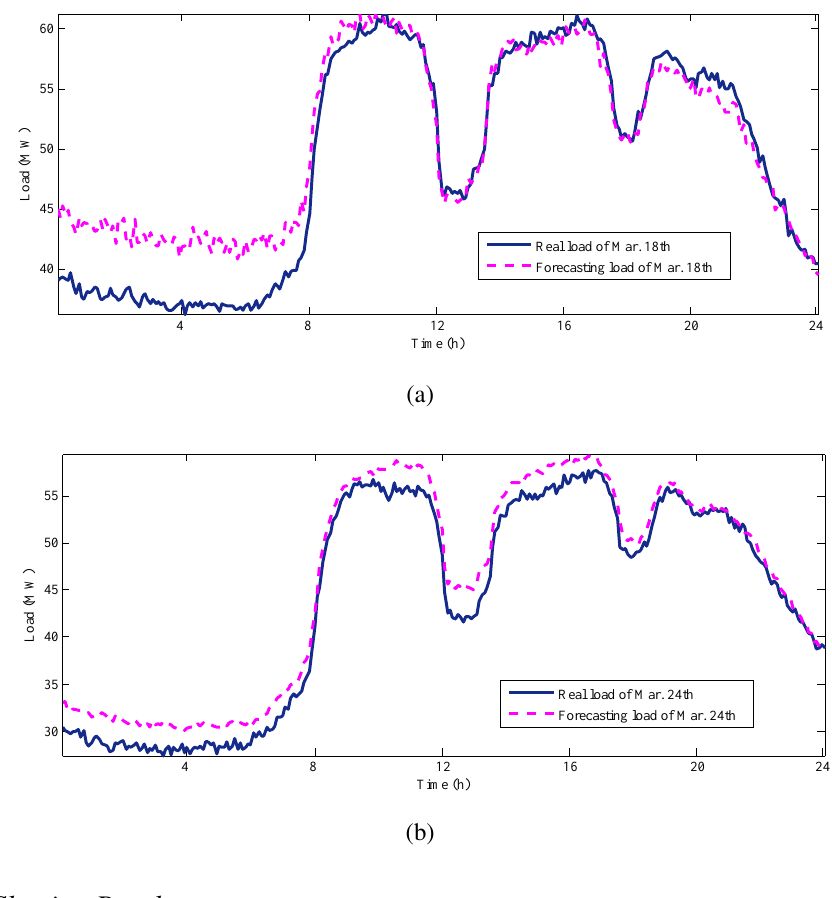
Figure 6. Daily load prediction results for two weekdays. ( a ) 18 March; ( b ) 24